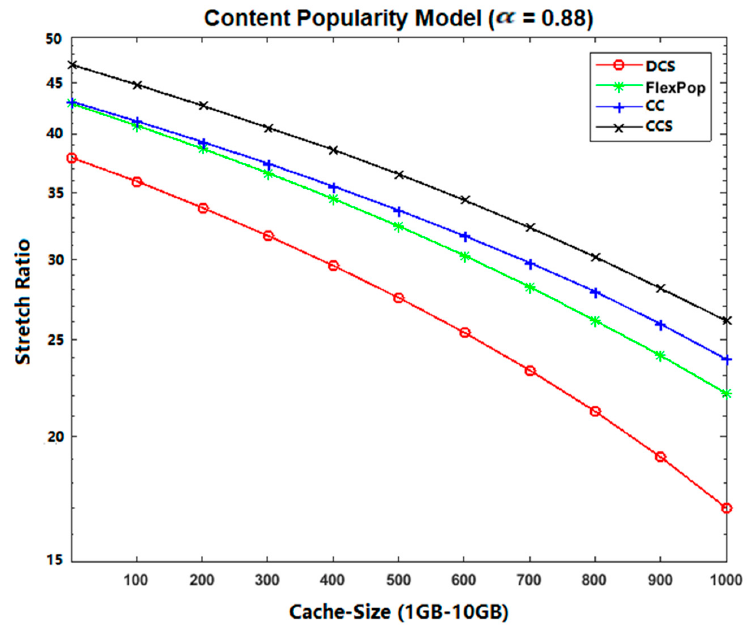
Figure 9. Stretch Ratio on Abilene Topology with UGC.